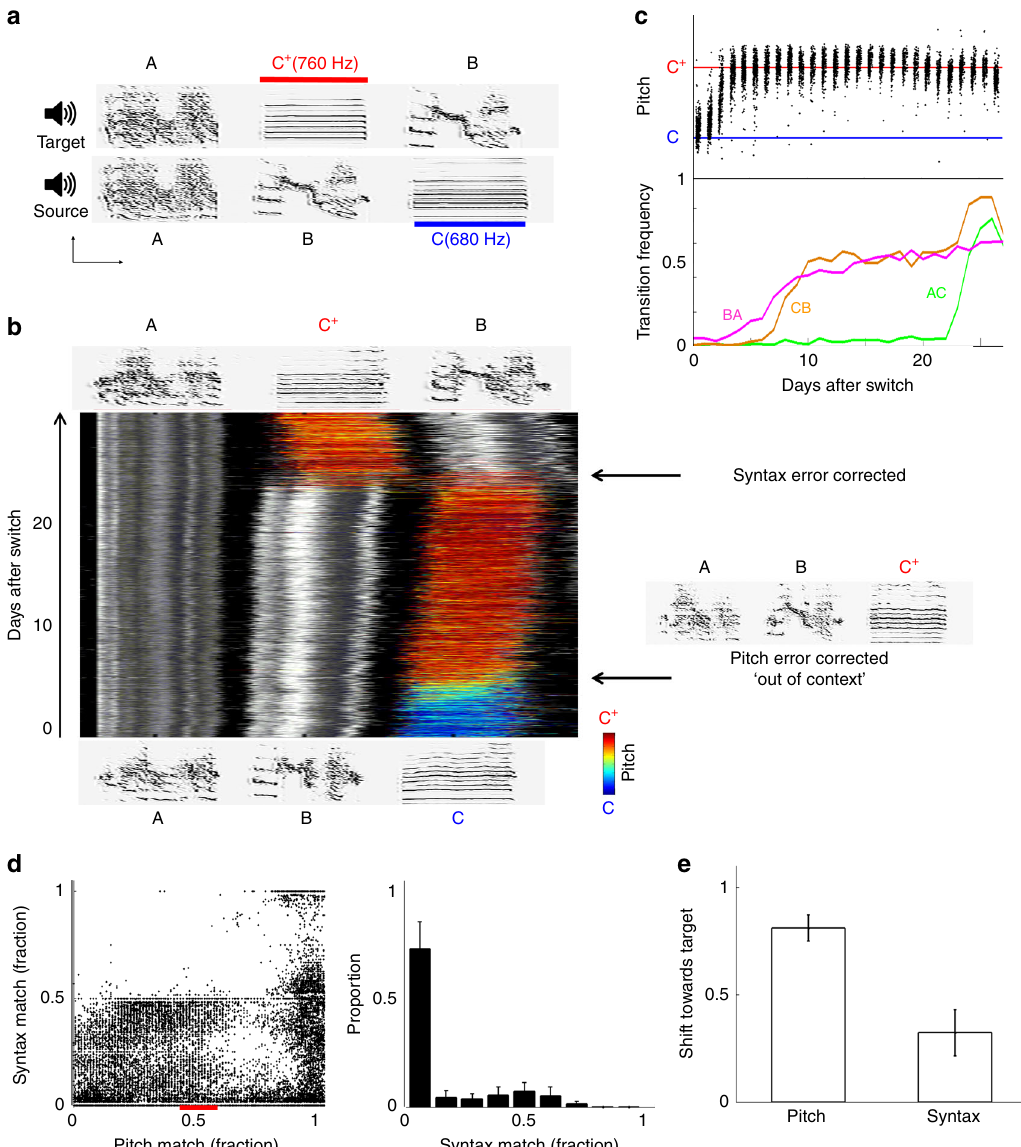
Fig. 2 Phonological error correction in individual syllables disregards global similarity. a Song models used for imitation task 1 ABC → AC + B (a single motif is shown; birds were trained with two motif repetitions). Scale bars for sonograms are 100 ms (x axis) and 2 kHz (y axis). The pitch of syllable C + in the target song is shifted up by two semitones with respect to C in the source. b Developmental singing trajectory of an experimental bird trained with imitation task 1. Stack plot shows consecutive renditions of song motifs containing C/C + syllables, over experimental days (day 0, switch to target training; instances of the transition BA, which the bird acquired early on, see c , are excluded from this plot). Colors, pitch of C/C + ; grayscale, Wiener entropy in neighboring syllables. Example sonograms of the bird ’ s song at experiment start (bottom) and end (top). The bird fi rst changed its song to ABC + (sonogram on the right ) and only afterwards corrected the syntax to AC + B (arrows). c Top, the median pitch of consecutive renditions of syllable C/C + in the same experimental bird; bottom, the daily frequencies of target syllable transitions. d Left, scatter plot of the fraction of syntax correction vs. the fraction of pitch correction (0, source pitch/syntax; 1, target pitch/syntax) in consecutive data bins (bin size 30 samples with 25 samples overlap) across experimental birds trained with imitation task 1 (ABC → AC + B; n = 3) and imitation task 2 (ABC → A + C + B, only syllable C/C + pitch correction included; n = 9; same for e ); right, distribution of the fraction of syntax correction at 45 – 55% pitch correction (red horizontal bar on bottom of left panel); means ± s.e.m. across birds for each bin. When pitch reached half way to target, syntax was mostly unchanged. e Fraction of pitch and syntax correction at developmental endpoint (0, source pitch/syntax; 1, target pitch/syntax; means ± middle). Such phonological greediness would increase the num- that many songbird species perform variable syllable sequences as ber of ensuing sequence changes and thus the overall sequencing adults (e.g., nightingales, starlings and Bengalese fi nches); and the cost 26 . An intermediate strategy could be to seek a trade-off ability of zebra fi nches to match a target exclusively through syllable rearrangements, without changing phonology 26 . An between minimizing structural and temporal errors, for example alternative strategy, therefore, could be to assign song syllables to by independently matching parts of the song sequence (such as target syllables in a manner that minimizes phonological phonology in bigrams or trigrams 27 ) to parts of the target distances, while ignoring combinatorial distances (Fig. 1c, sequence (Fig. 1c, right).